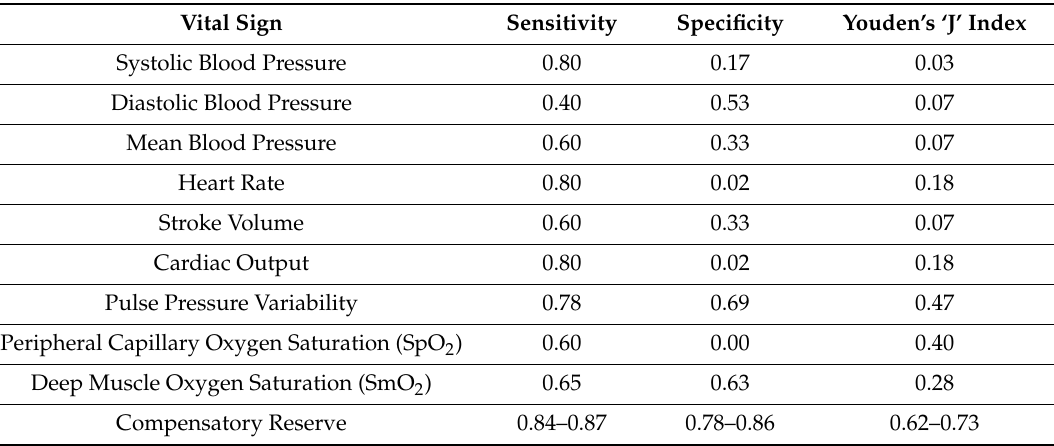
Table 2. Sensitivity, specificity and Youden’s J index of traditional vital signs and hemodynamic responses for prediction of the onset of decompensated shock secondary to progressive central hypovolemia. Modified from Convertino et al.